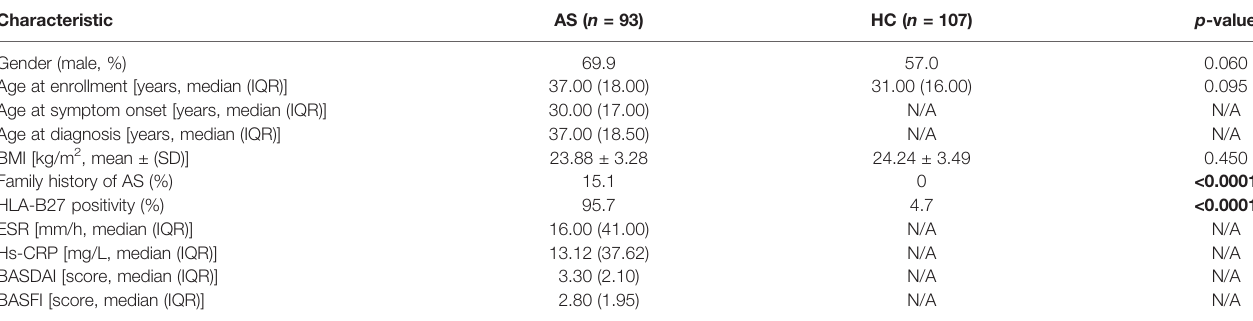
TABLE 1 | Demographic and clinical characteristics of ankylosing spondylitis (AS) patients.